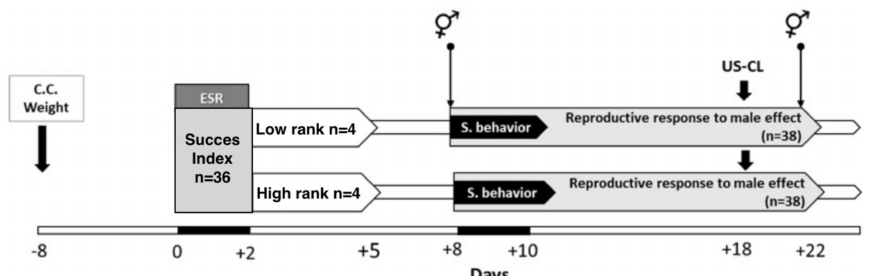
Figure 1. Timeline of actions. The social rank evaluation (ESR) was carried out for two days. During the test of sexual behavior (S. behavior), low (LHR) and high (HHR) hierarchy rams were exposed to anovulatory ewes for two consecutive days/two hours. Morphometric characterization is described in the text, BCS = body condition score, Weight = live weight. The reproductive response of ewes was recorded with either LHR or HHR twice a day (08:00 and 18:00 h). An ultrasound scanning for corpora lutea detection (US-CL) was performed 10 d after the introduction of